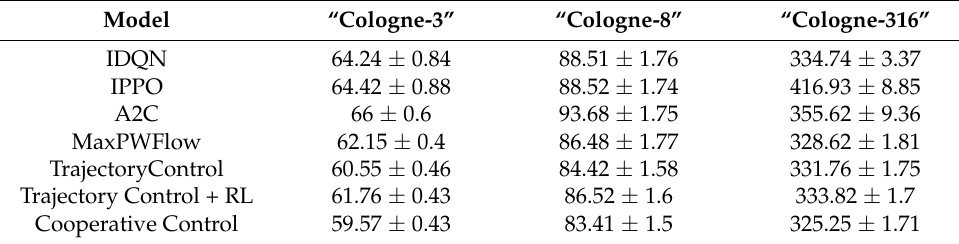
Table 2. Average fuel consumption (ml) for different simulation scenarios.